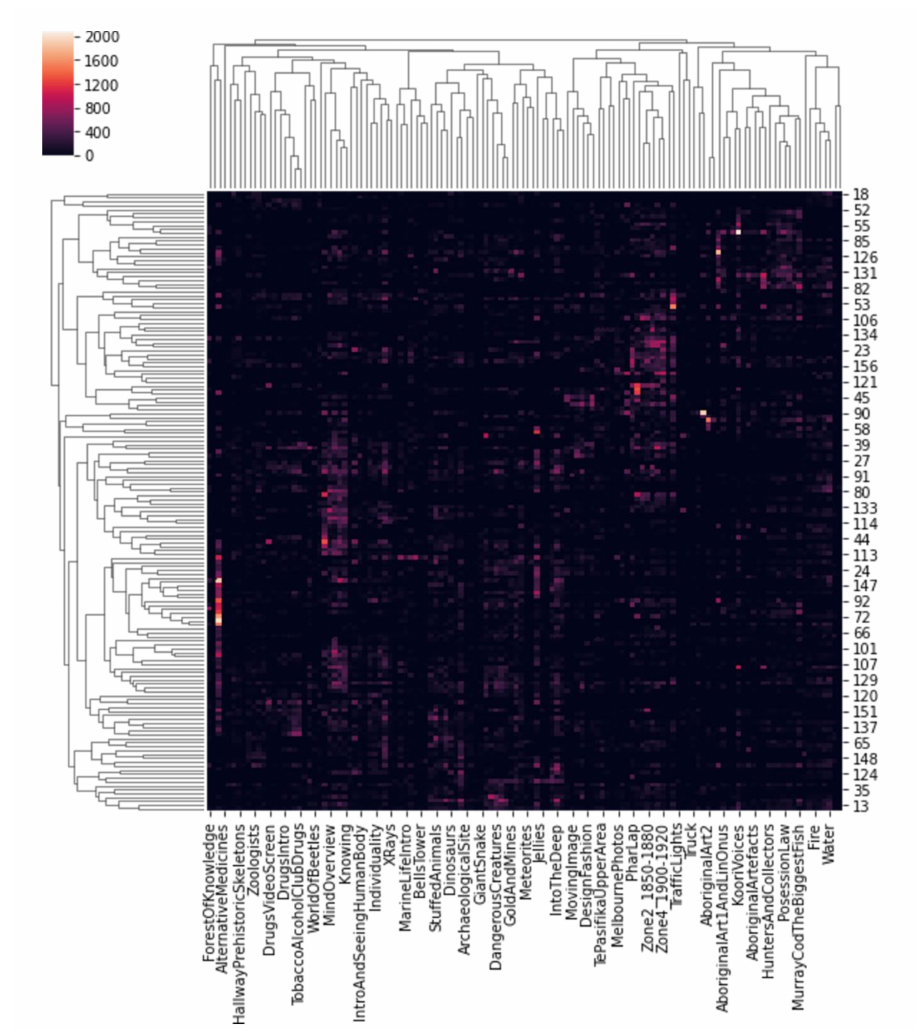
Figure 14. Clustering of Melbourne Museum exhibit areas based on correlations at different levels of hierarchies and visit durations.